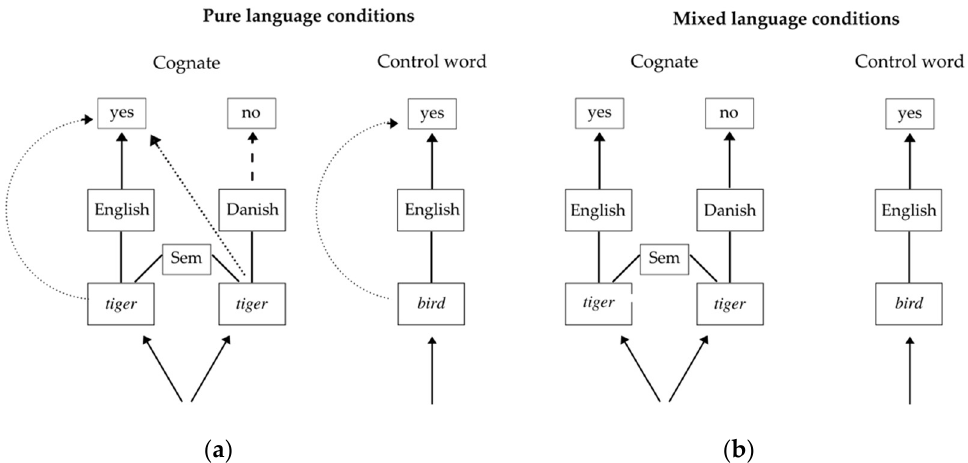
Figure 1. Illustration of stimulus–response bindings for interlingual cognates and target language control words in pure language conditions ( a ) and mixed language conditions ( b ). For the sake of simplicity, phonology is not considered. Dotted lines indicate shortcuts, and dashed lines indicate weaker stimulus-response bindings. Extended from Dijkstra (2005) and Vanlangendonck et al. (2020).